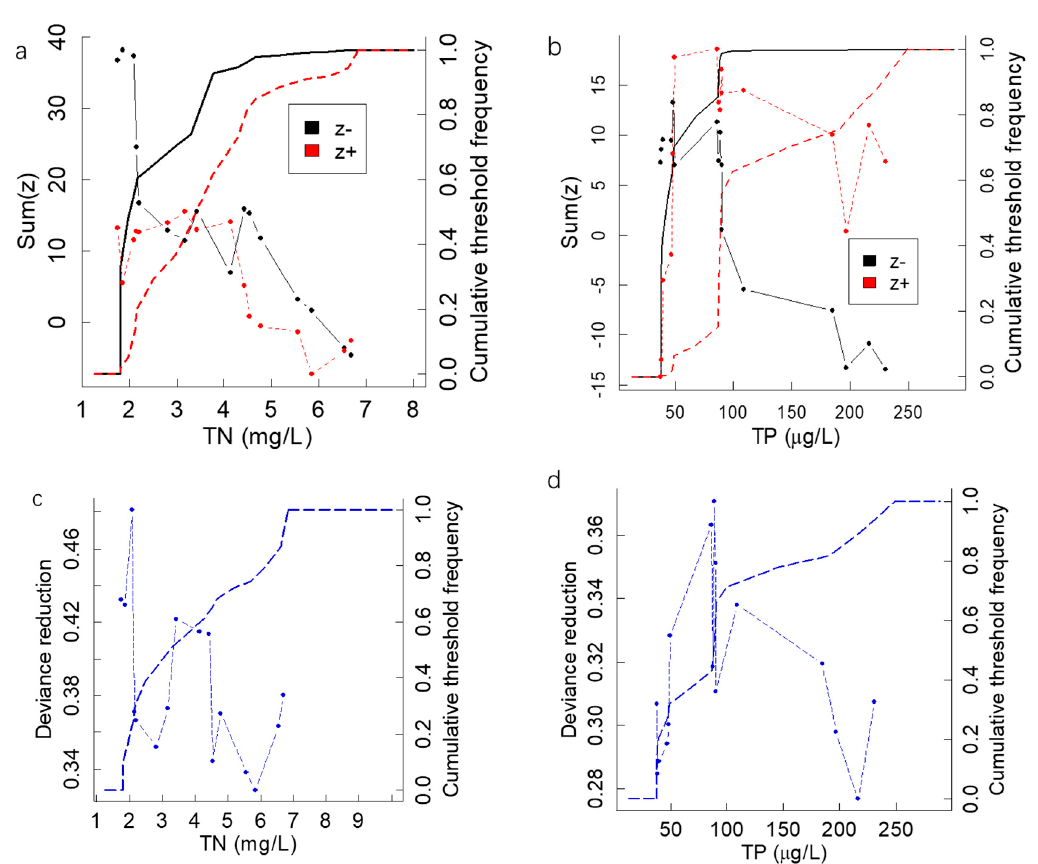
Figure 4. The TITAN sums of negative (z − ) and positive (z+) responding species to all candidate change points along the TN and TP gradients ( a , b ). The deviance reduction in the Bray–Curtis distance values for the candidate change points of the phytoplankton community along TN and TP gradients and the cumulative frequency distribution of the change points among the bootstrap replicates ( c , d ). The dotted lines respectively represent the responses of negative responding species (z − ) and positive responding species (z+) along the nutrient gradients, while the broken lines represent the cumulative frequency distribution of the change points among the bootstrap replicates. (a) title; (b) title; (c) title; (d) title.